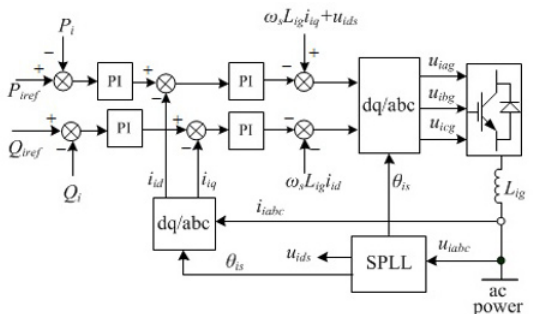
Figure 5. Real power control